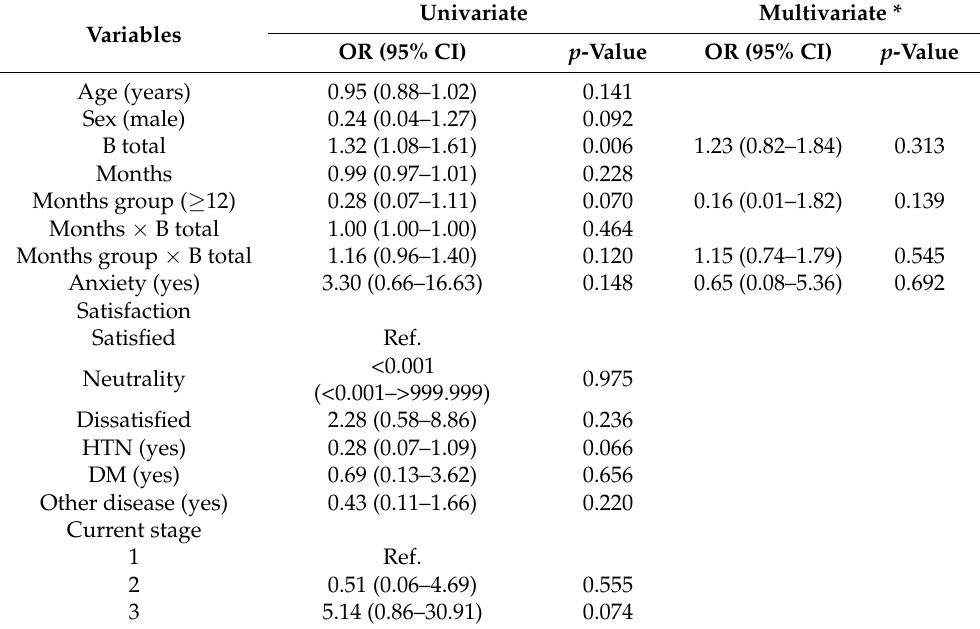
Table 2. Logistic regression of suicidal ideation.